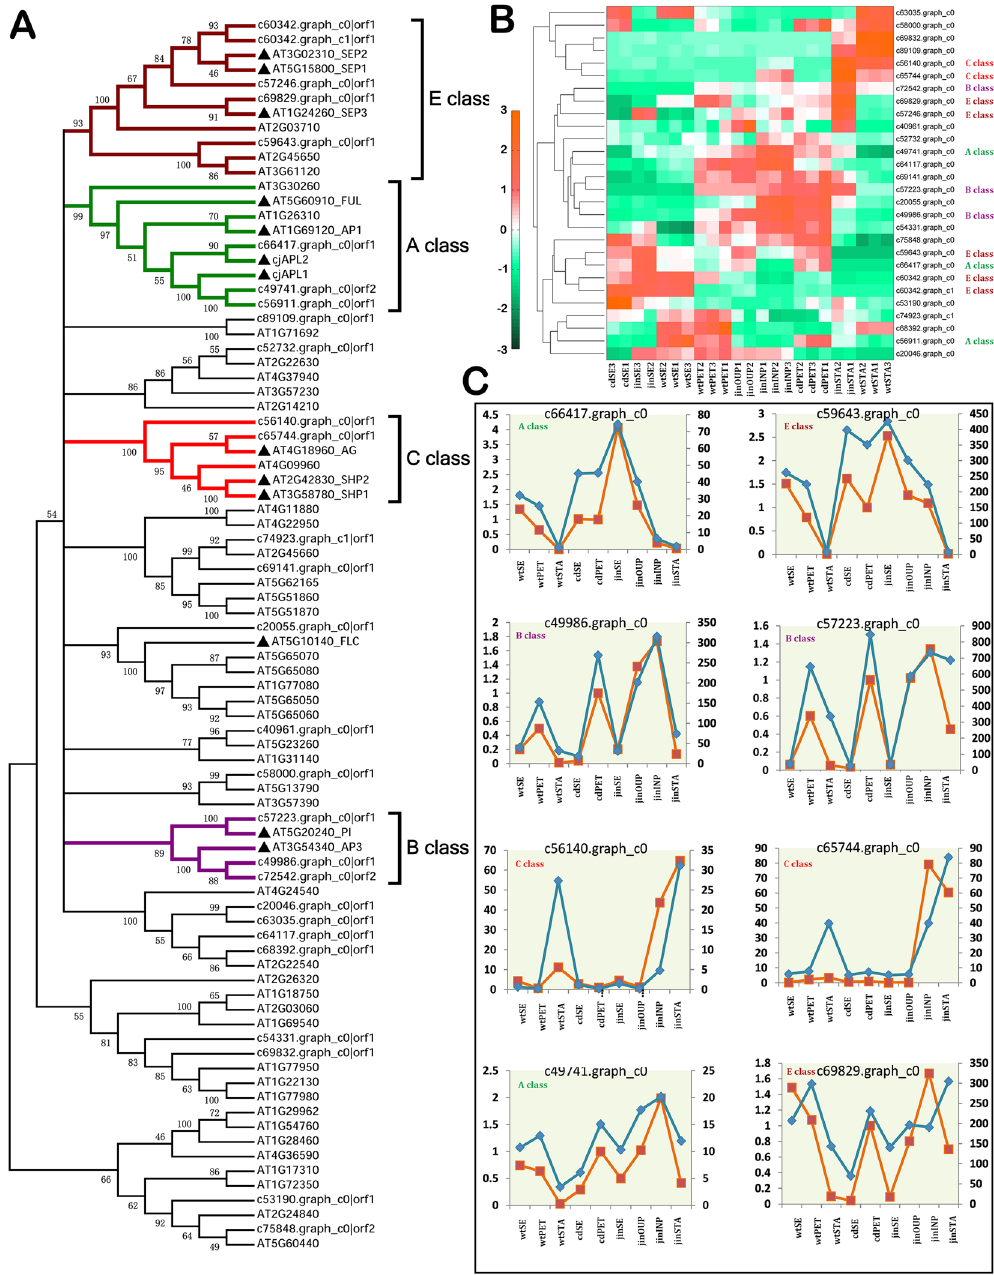
Figure 4. Identification and expression analyses of MADS-box genes. ( A ) The phylogenetic tree of MADS-box genes in Arabidopsis and C. japonica , and subgroups of functional characters were identified by annotation from Arabidopsis. Colored branch indicated a subgroup of MADS genes based on the ABCE genes in Arabidopsis. ( A , B ) heatmap plot of expression patterns of MADS-box genes from C. japonica . The genes that were classified in ABCE categories as shown in ( A ) were labeled. Expression levels of samples were normalized by z-score and plotted. ( C ) Comparisons of expression profiles of key MADS-box genes by RNAseq and qPCR analyses. In each panel, the blue line indicated values of qPCR experiments referring to the left y-axis, and the orange line indicated RPKM values of RNA-seq referring to the right